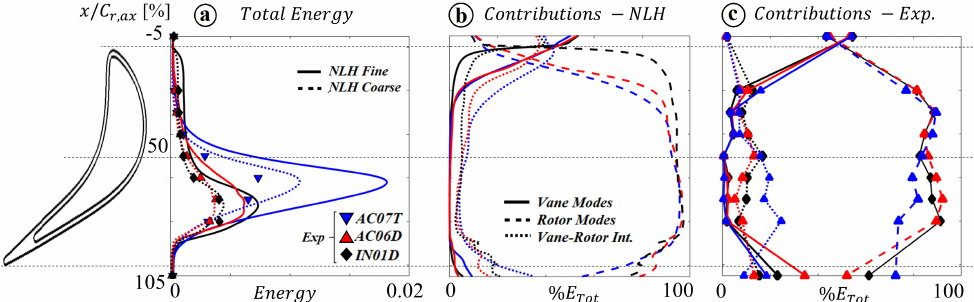
Figure 10. Modal decomposition of over-tip casing static pressure field: total energy ( a ) and relative energy spectra from numerical predictions ( b ) and experiments ( c